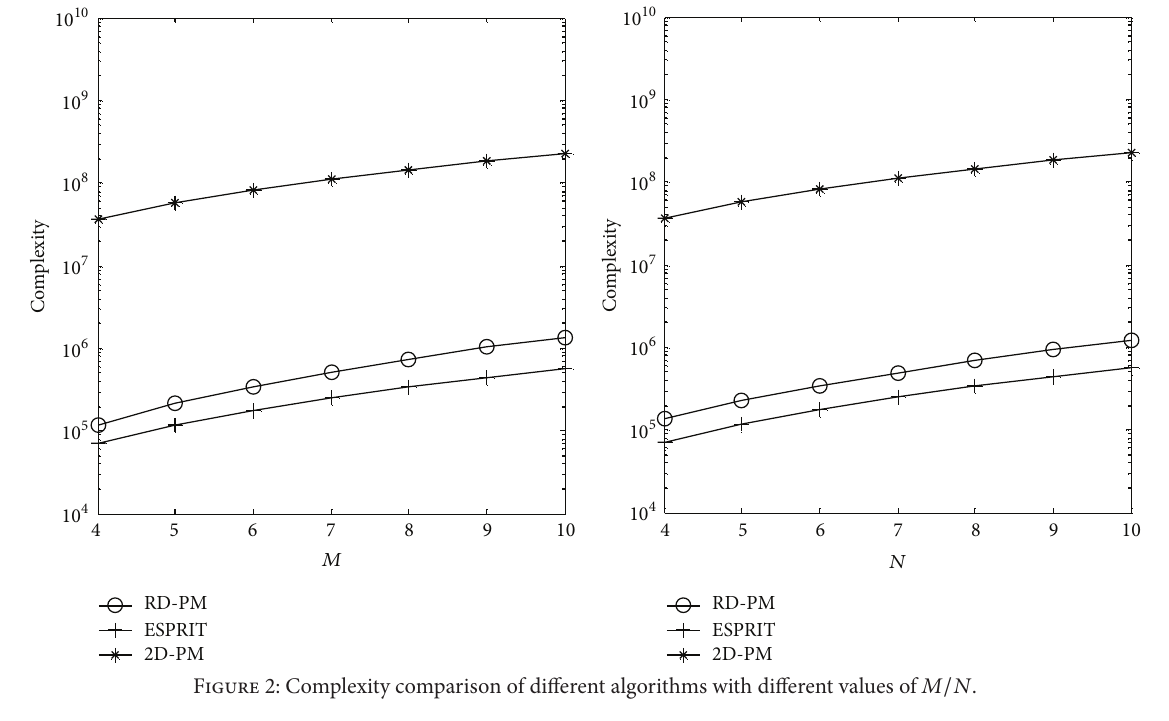
Figure 2: Complexity comparison of different algorithms with different values of 𝑀/𝑁 .